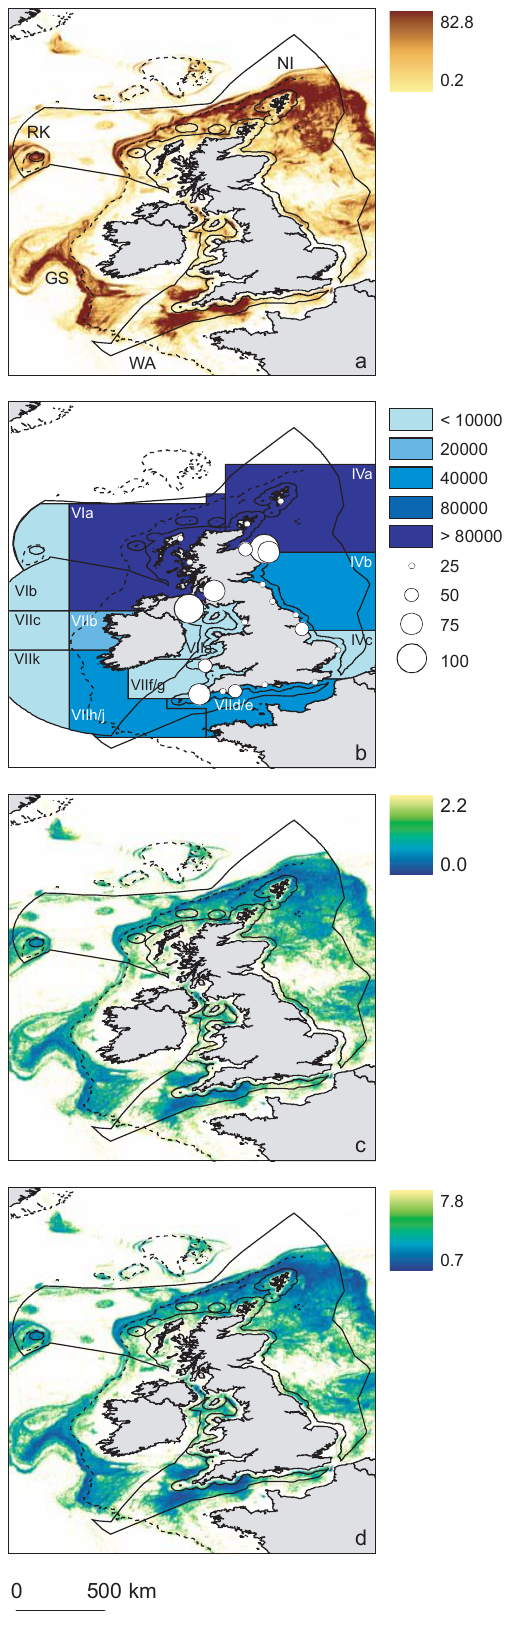
Figure 1. a) Mean annual spatial distribution of fisheries activity derived from VMS records using a simple speed filter. The colour